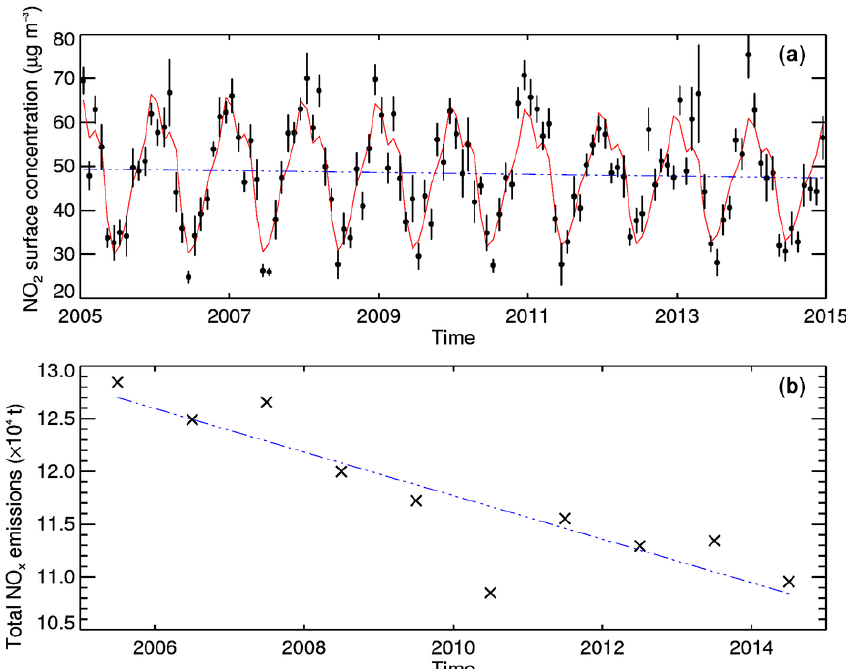
Figure 8. Top panel: time series analysis of the monthly mean surface NO 2 between 2005 and 2015 predicted by Model 1 (see Table 2) over the region covering Kowloon and Hong Kong Island shown in Fig. 1. The error bars represent the standard error of the mean for each month, while the red line represents the linear trend and seasonal cycle modelled using Eq. (4). The linear trend is also shown separately as the blue dashed line. Bottom panel: the annual total NO x emissions by Hong Kong, as estimated by the HKEPD bottom-up inventory (HKEPD,